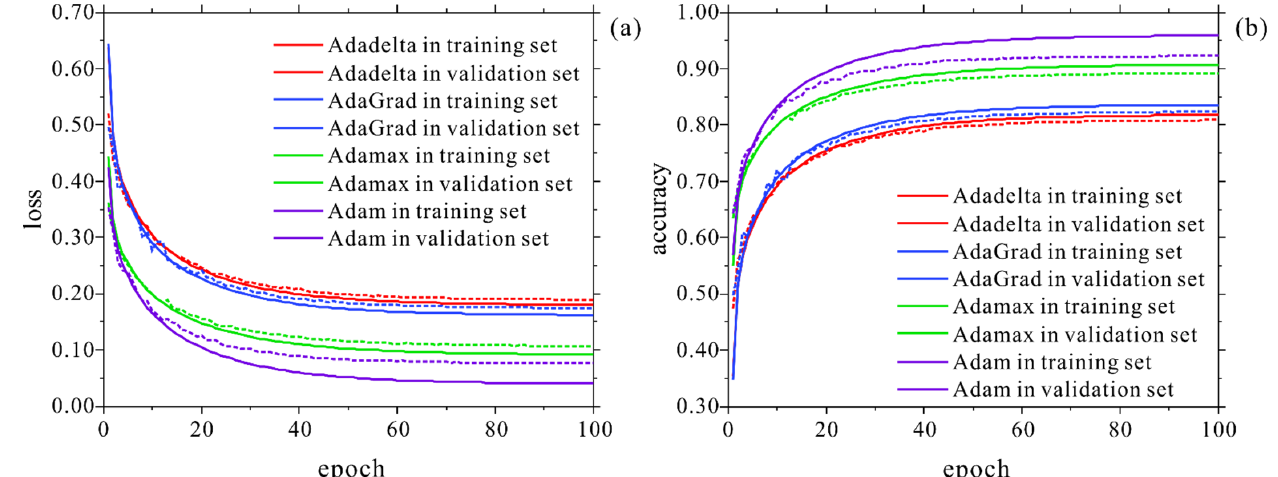
Figure 11. The model ′ s performance curve with different optimizers. ( a ) loss curve, ( b ) accuracy curve.